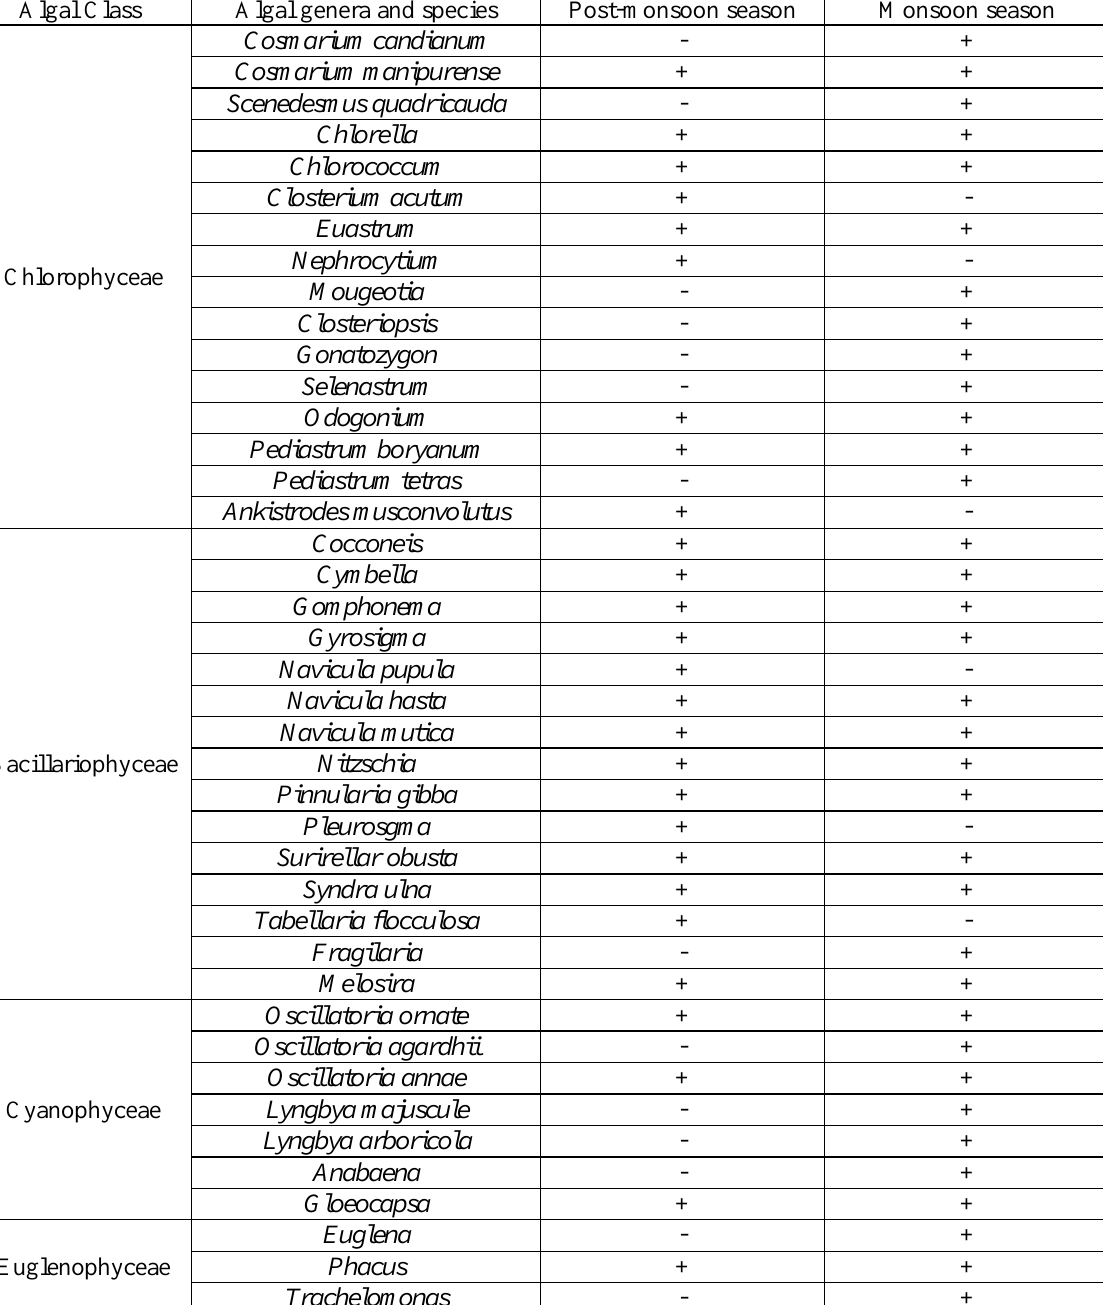
Table 1. Seasonal algal diversity in the midstream of the Achankovil River Algal Class Algal genera and species